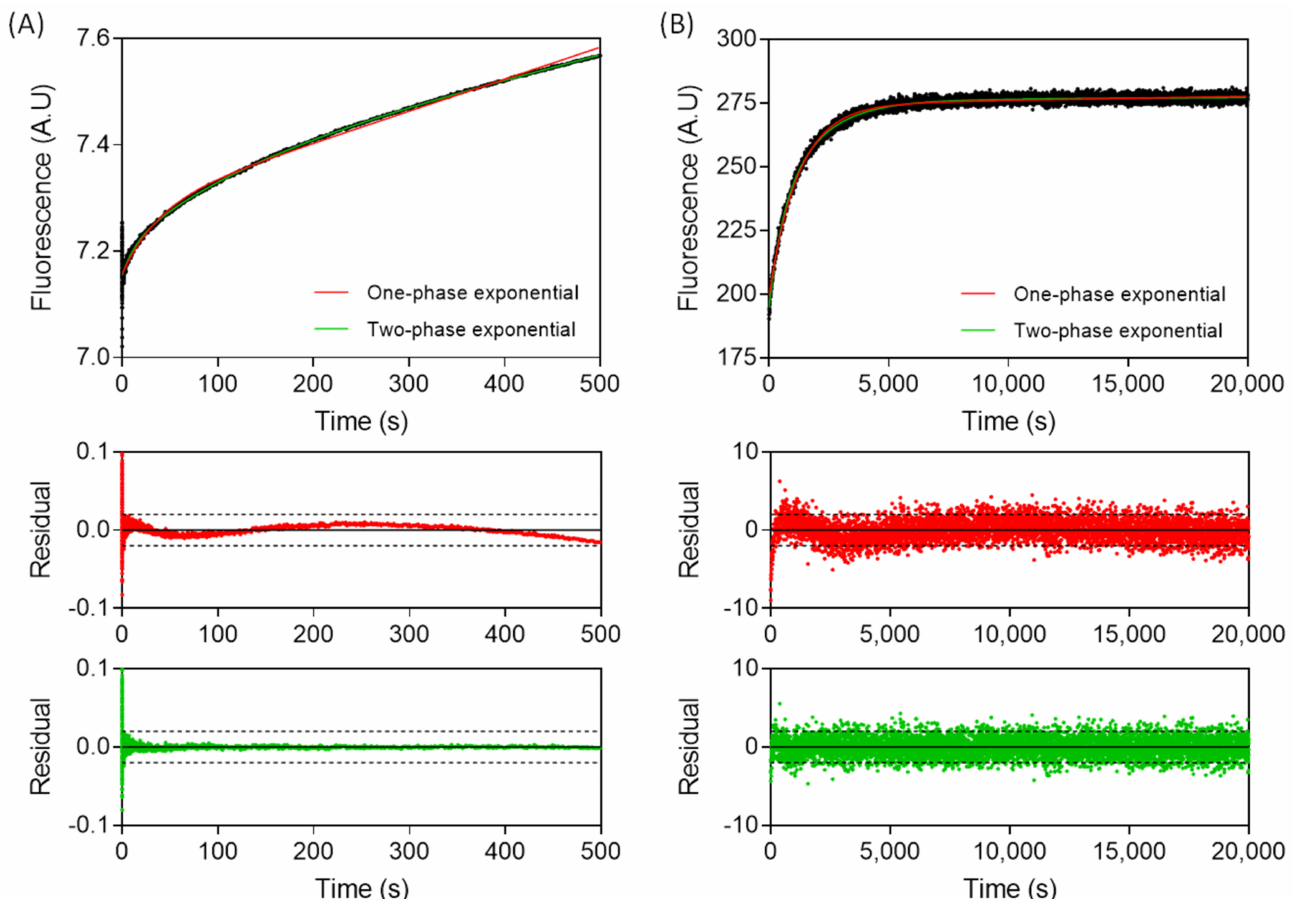
Figure 4. Stopped-flow and time-dependent fluorescence spectroscopy measurements of the dissociation of the WT TCF7L2– β -catenin complex. First, a 200 nM fluorescent-labelled WT TCF7L2– β -catenin complex was mixed in with 50-times molar excess of unlabelled WT TCF7L2 (1–54), and the reaction was monitored by ( A ) stopped-flow fluorescence and ( B ) fluorescence. The traces were fitted to a single exponential phase and to the sum of two exponential phases, and the corresponding residuals are plotted below the main plot. Experiments were performed in a PBS buffer, 1 mM DTT at 15 ◦